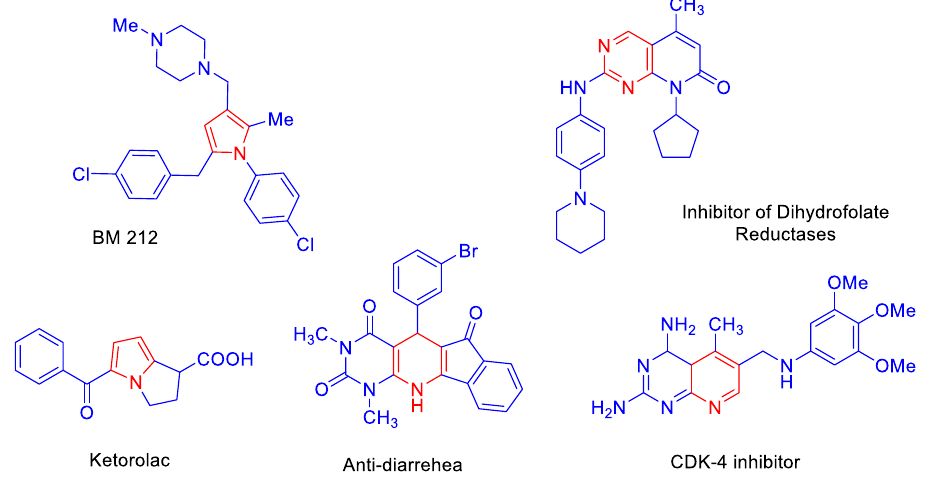
Figure 1. Structure of N -heterocycle rings as drug candidates.